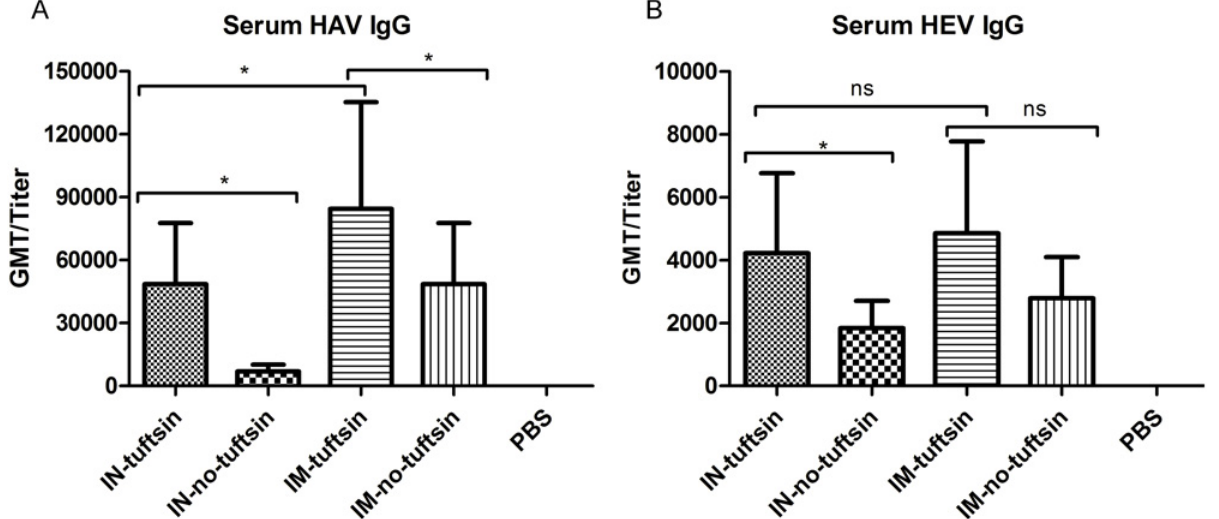
Fig 2. Profiles of total IgG production in humoral immune response to vaccination. (A) Anti-HAV IgG and (B) anti-HEV IgG were detected by indirect ELISA after immunization of the immunized groups as indicated. The IN-tuftsin group was intranasally administered HE-ORF2-tuftsin + HA-VP1-tuftsin + CpG. The IN-no-tuftsin group was intranasally administered HE-ORF2 + HA-VP1 + CpG. The IM-tuftsin group was intramuscularly administered HE-ORF2-tuftsin + HA-VP1-tuftsin + CpG. The IM-no-tuftsin group was intramuscularly administered HE-ORF2 + HA-VP1 + CpG. Each serum effective dose (presented as the GMT) is the reciprocal value of the maximum positive dilution. Error bars represent the standard error of the mean (SEM). * , P < 0.05, ** , P < 0.01, *** , P < 0.001; ns, no significant difference.